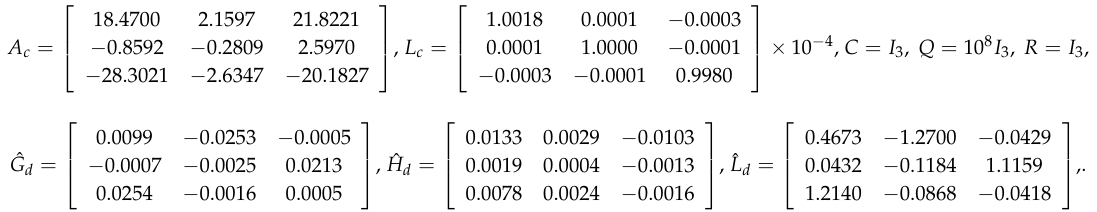
Table 1. The error range of the outputs values ( (cid:101) y 1 ( t ) , (cid:101) y 2 ( t ) , (cid:101) y 3 ( t ) ) of the OKID and OKID combined digital redesign